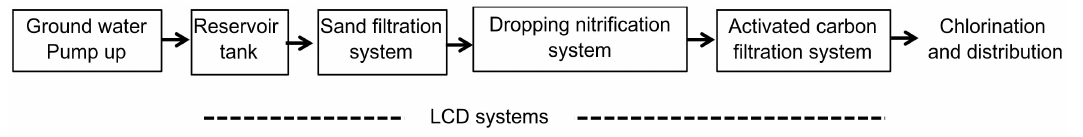
Figure 2. Flow diagram of the LCD (Locally-fitted, Compact, and Distributed) water treatment